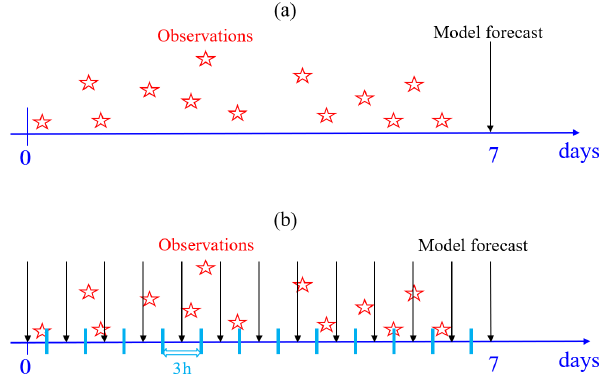
Figure 8. Schematic representation of the FGAT method: (a) not used in SCSOFSv1 and (b) used in SCSOFSv2. Red stars denote the observations, and the black arrows denote the archived snapshots of model